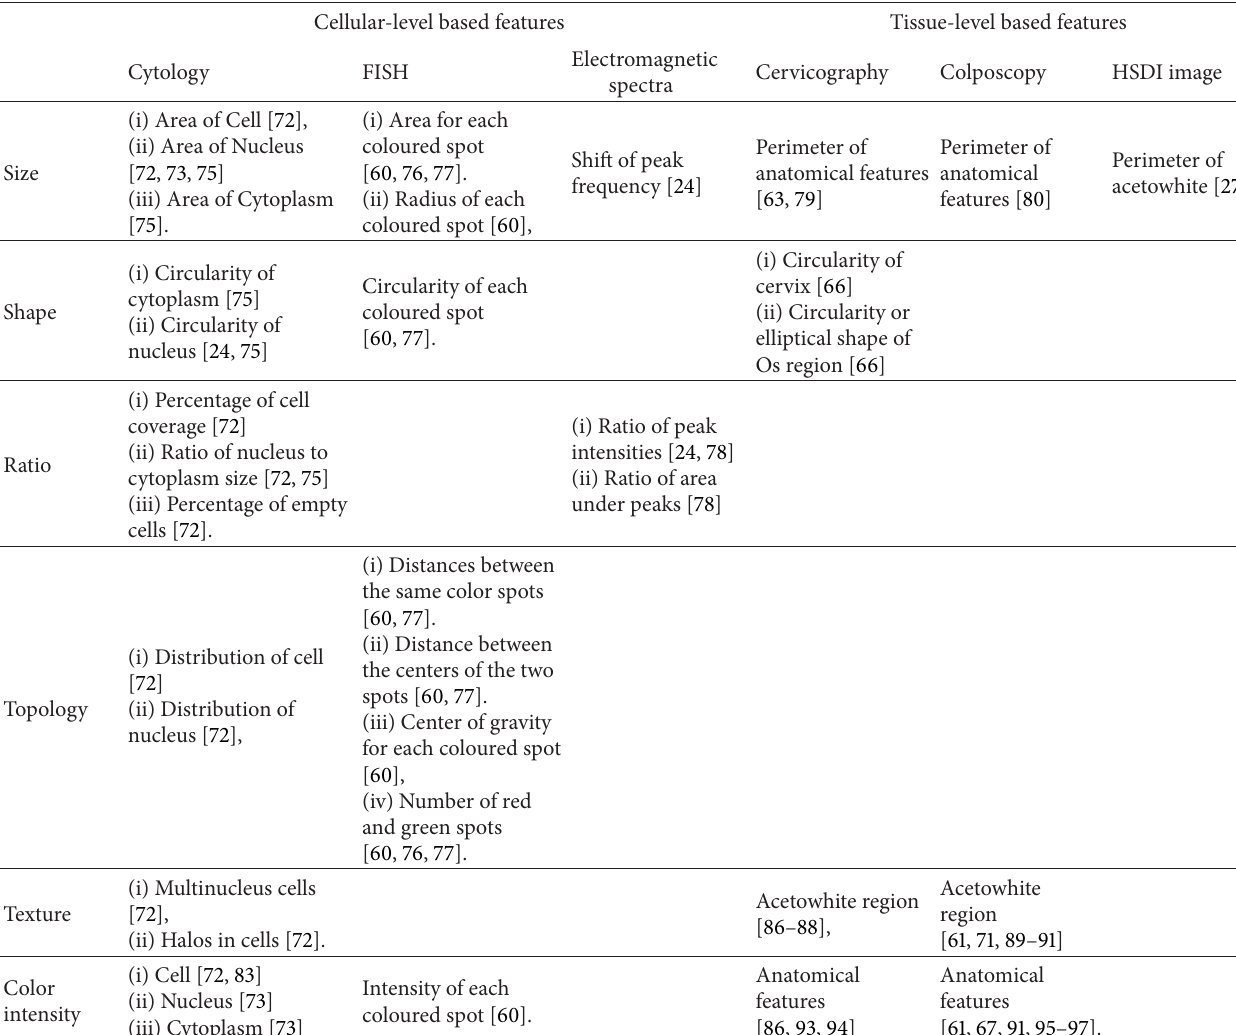
Table 3: The list of features that are extracted by different